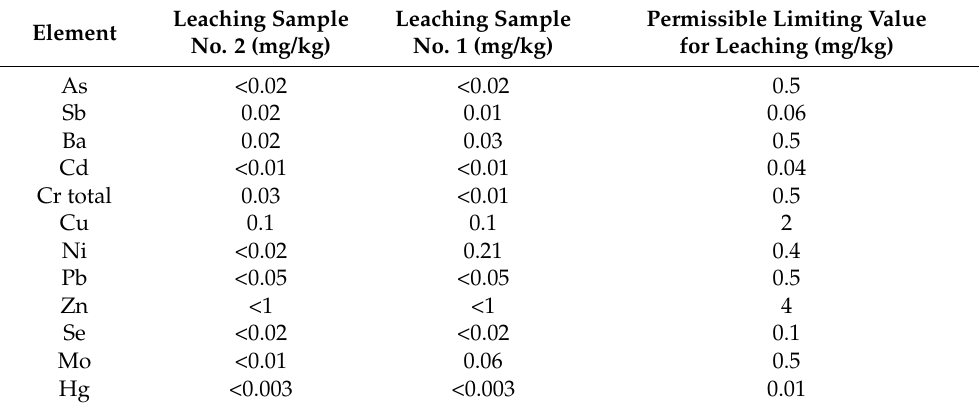
Table 4. Results on the leaching values of heavy metals from vitrified samples.